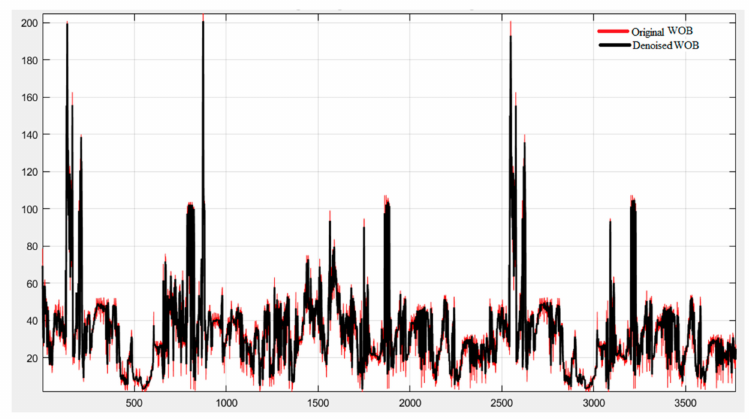
Figure 5. The denoising of WOB variable using the 1-D Wavelet filtering